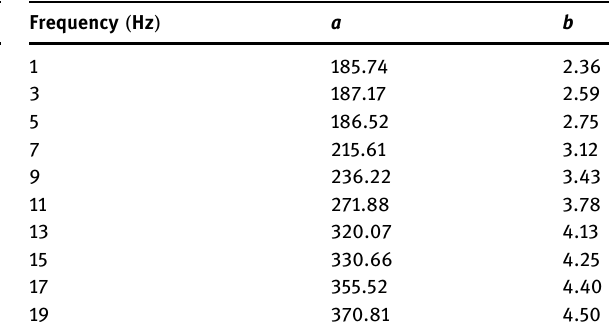
Table 2: Fitting parameters of storage modulus Table 3: Fitting parameters of loss modulus